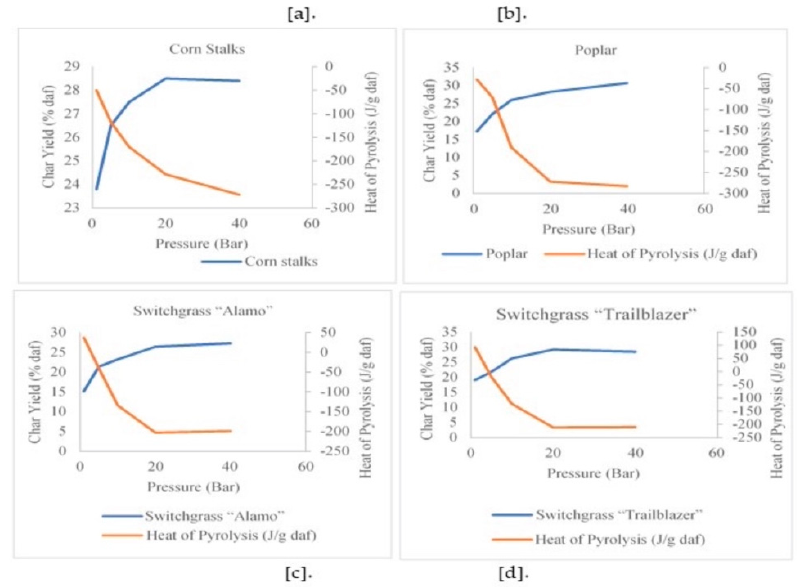
Figure 4. The influence of pressure on heat of pyrolysis for ( a ) corn stalks (with biomass weight of volatiles = 77.7%, fixed carbon =16.0%, and ash = 6.3%); ( b ) poplar (with biomass weight of volatiles = 81.8%, fixed carbon = 14.8%, and ash = 8.4%); ( c ) switchgrass Alamo (with biomass weight of volatiles = 79.3%, fixed carbon = 12.1% and ash = 2.1%); and ( d ) switchgrass Trailblazer (with biomass weight of volatiles = 64.1%, fixed carbon = 8.6%, and ash = 27.3%) [1].